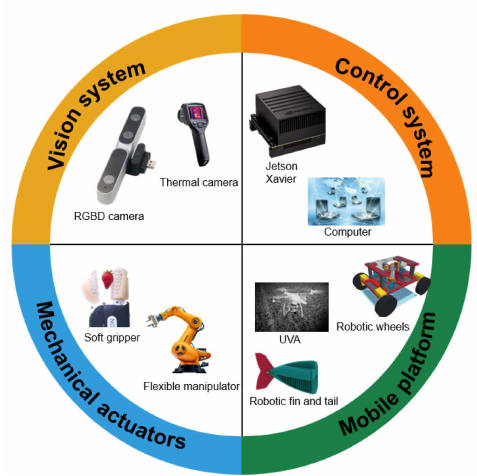
Figure 4. Components of agricultural robots